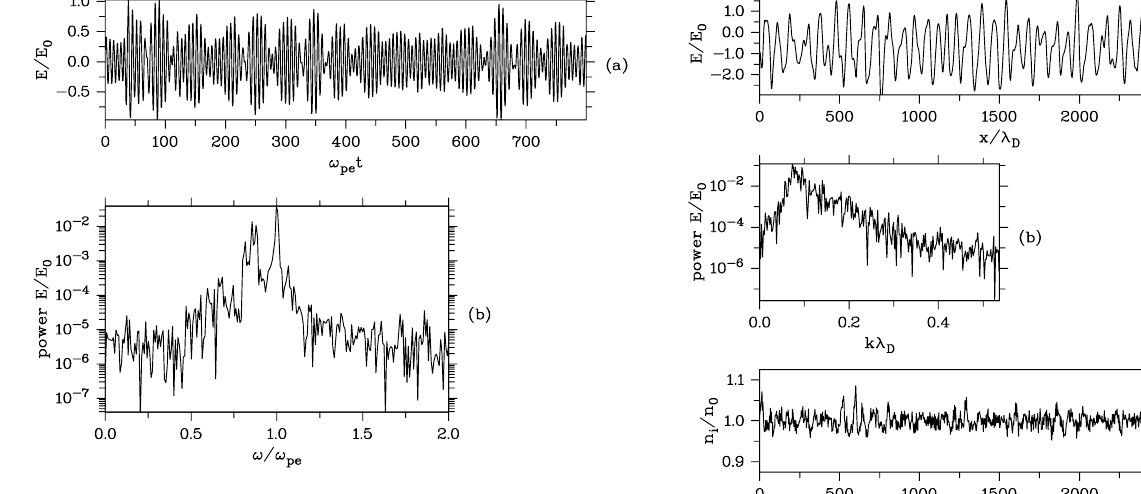
Figure 8. Beat-type waveform generated by a dense beam n b /n 0 = 0 . 05 at position x/λ D = 2400 in the box (a) , and corresponding power spectrum (b) with two distinct peaks. Beam velocity V b = 8 v the .